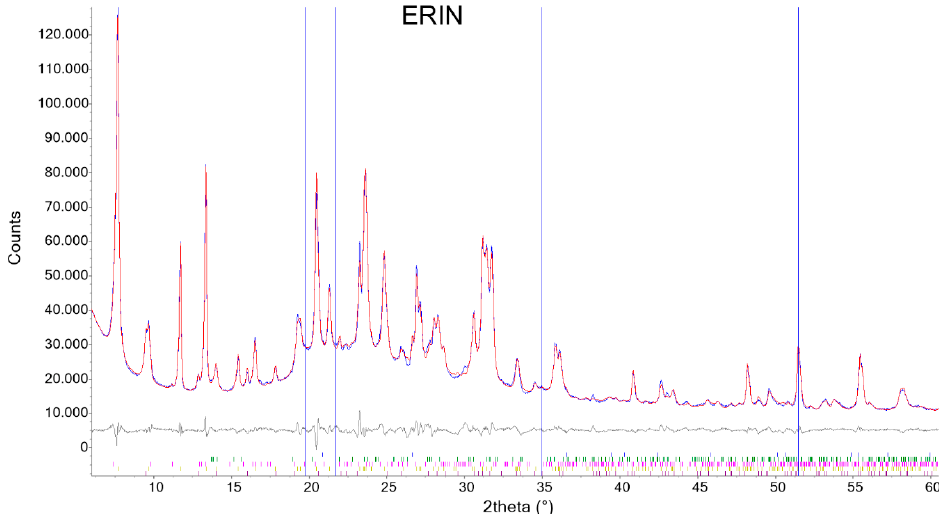
Figure 5. Magnified view (6°–60° 2 θ ) of the conventional Rietveld plots of the ERIN sample. Blue dots: Experimental pattern; red continuous: Calculated pattern; gray continuous: difference plot; vertical lines: position of the relevant reflections of clays.